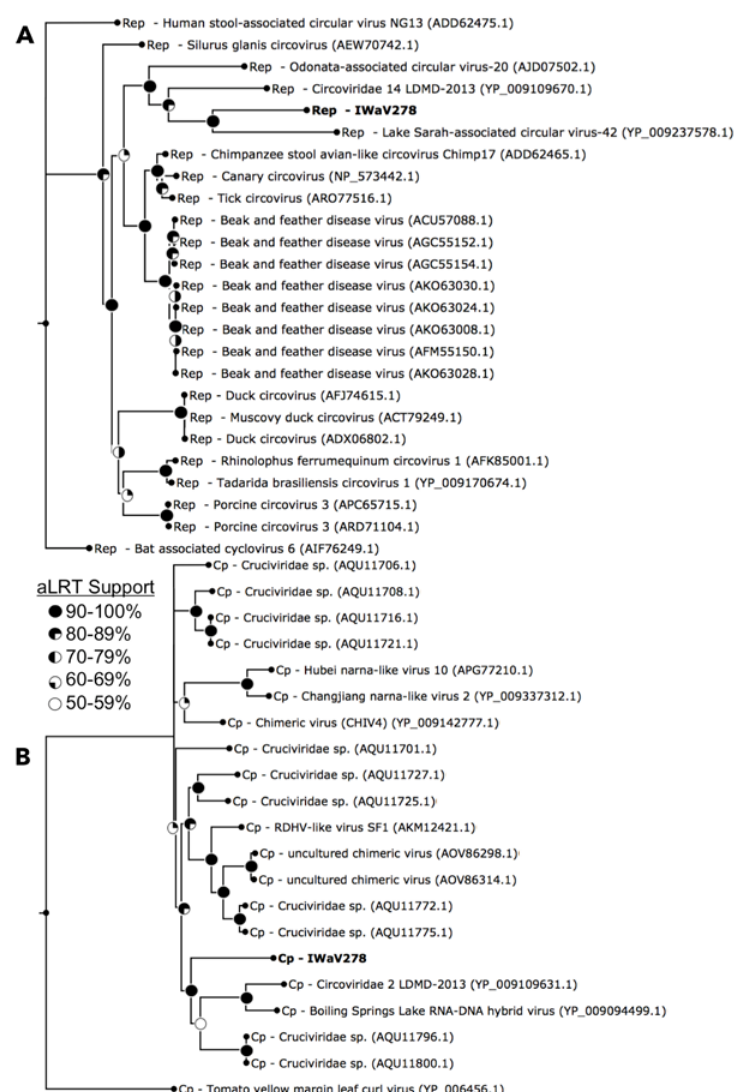
Figure 2. Maximum likelihood phylogeny of Rep ( A ) and Cp ( B ) open reading frames. Phylogenies were constructed via smart model selection (Rep: LG+G+I, Cp: RtREV+G+F) implemented in PhyML and visualized via FigTree v.1.4.2. Terminal nodes indicate IWaV278-ORFs and associated best